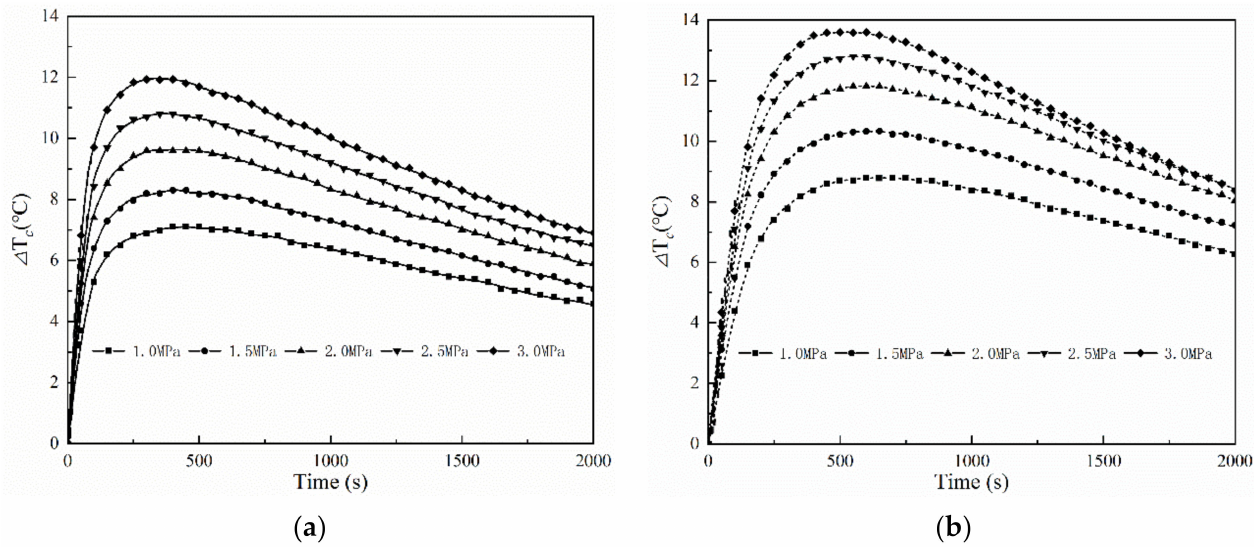
Figure 4. Temperature variation with time at the different positions of 30~60 mesh coal samples: ( a ) temperature sensors #1; ( b ) temperature sensors